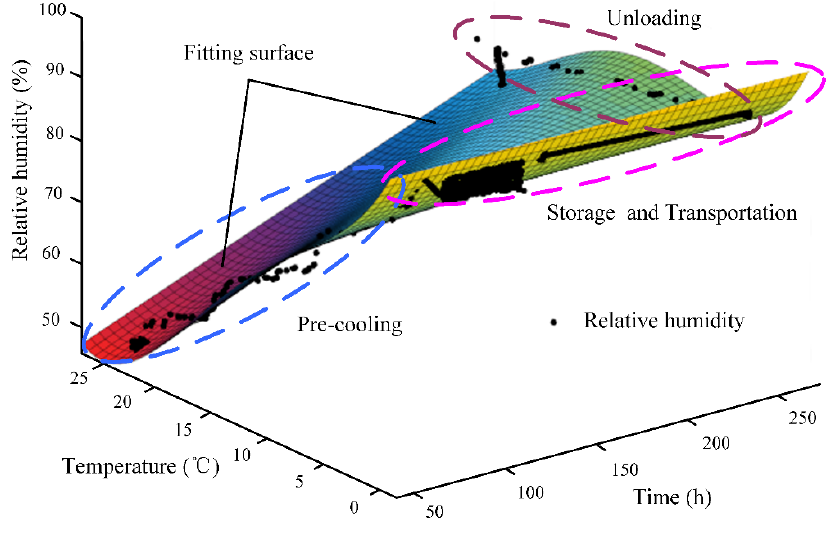
Figure 6. Temperature and relative humidity in the cold chain logistics after data